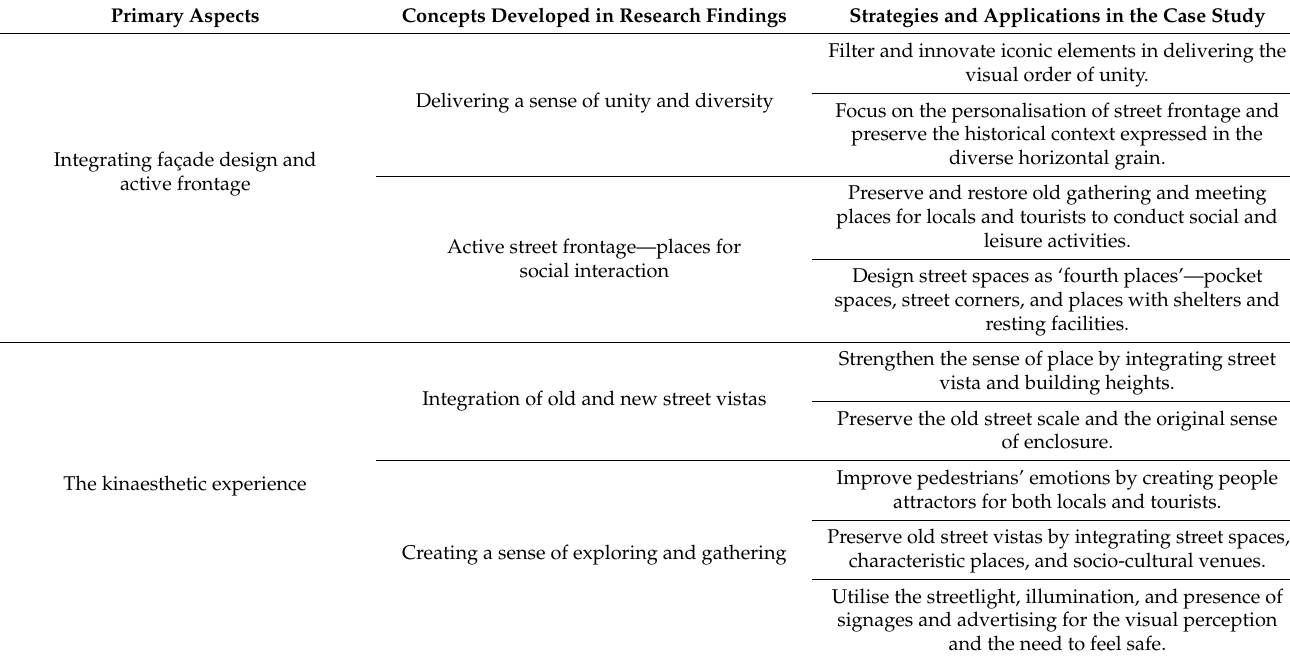
Figure 15. The conceptual framework developed in this research. Source: Author. Table 2. The new conceptual framework developed in the